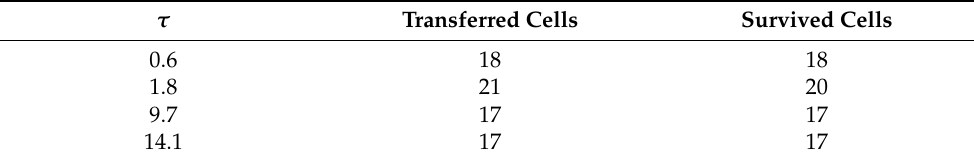
Figure 4. Microscopy images of the transferred hMSC cells on the gelatin-coated acceptor slide after printing. To determine the cell survival rate after transfer, cells were stained with propidium iodide (red PI staining indicates dead cells, live cells are displayed in green). Table 2. Cell survival after transfer of hMSC cells with varying pulse